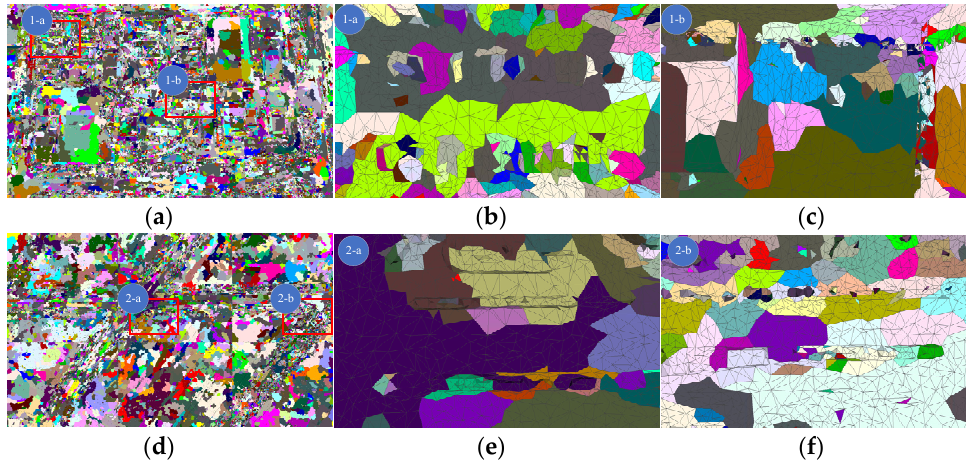
Figure 16. Texture charts obtained via the Waechter algorithm. ( a ) texture charts for building area; ( b , c ) the texture charts of building area via Waechter method; ( d ) texture charts for nonbuilding area; ( e , f ) the texture charts of nonbuilding area via Waechter method. red frame is the local detail area; red circle is the experimental comparison area.